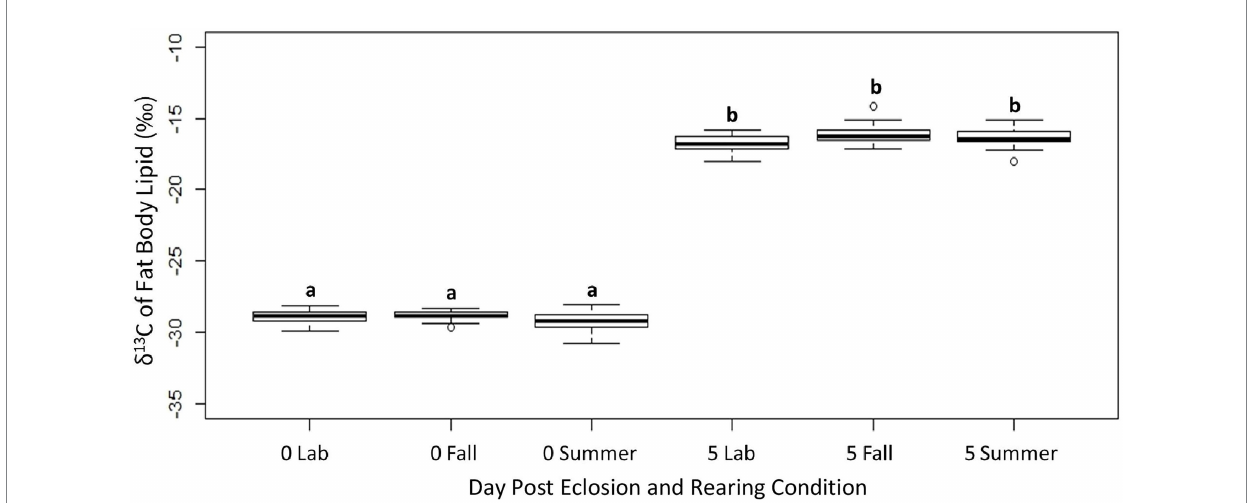
FIGURE 2 The δ 13 C values of the fat body from non-flown true armyworm adults fed sugar water ad lib as a function of age and rearing conditions. Significant differences are indicated by different letters (Tukey’s HSD, p < 0.05). N = 20 per sample